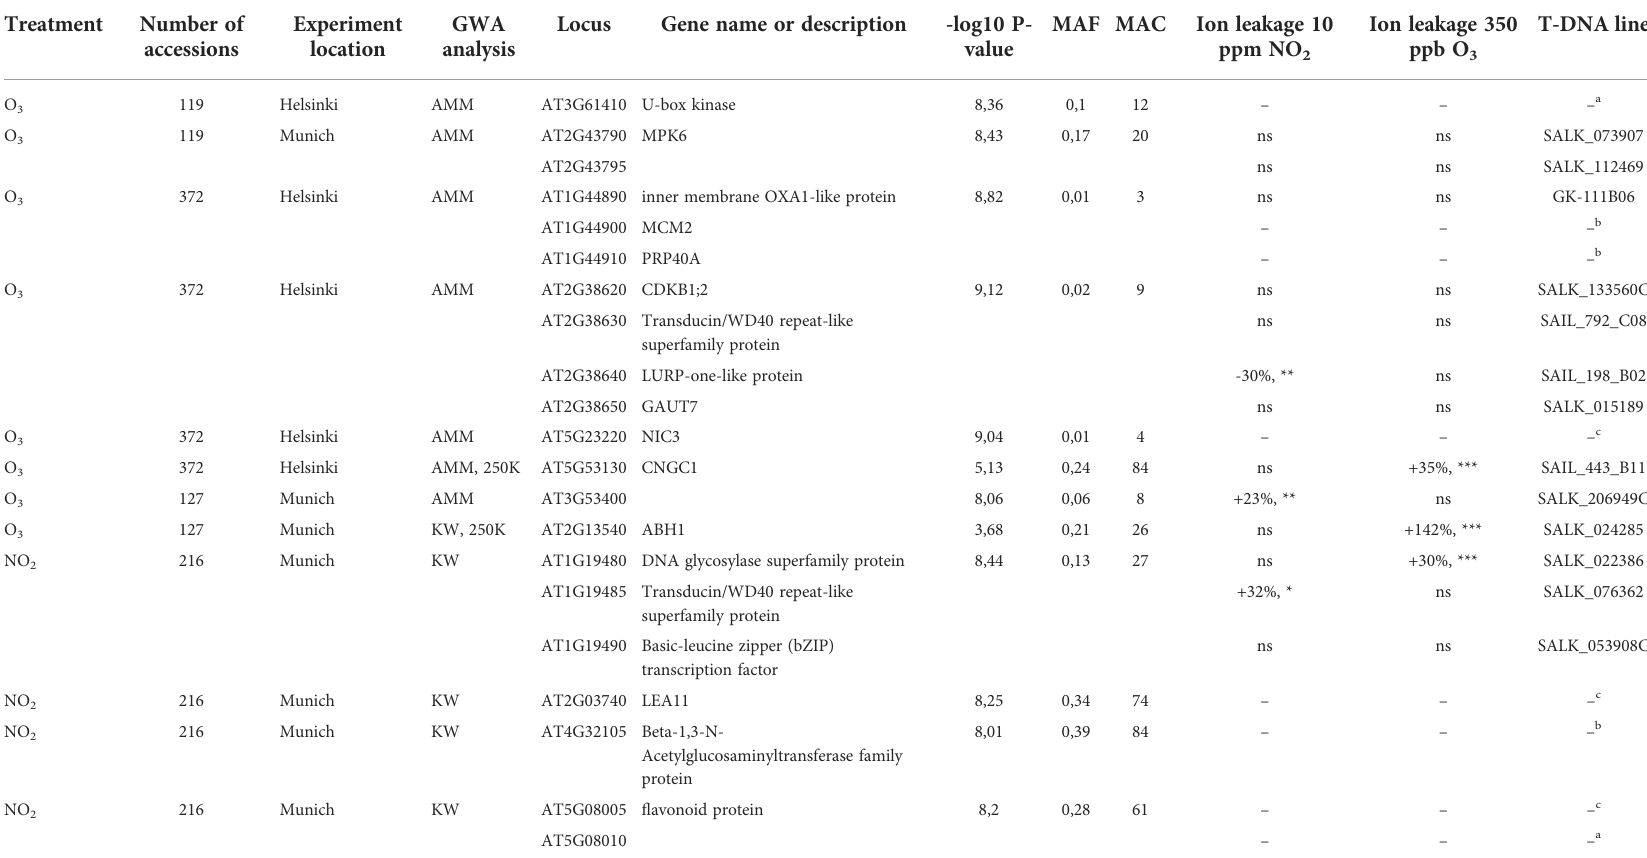
TABLE 1 Identi fi ed GWAS candidate genes, -log10 P-value of the most signi fi cant SNP in the regions, minor allele frequency and count of the most signi fi cant SNPs, signi fi cant differences in ion leakage measurements of the candidate gene mutants relative to Col-0 control after NO2 and O3